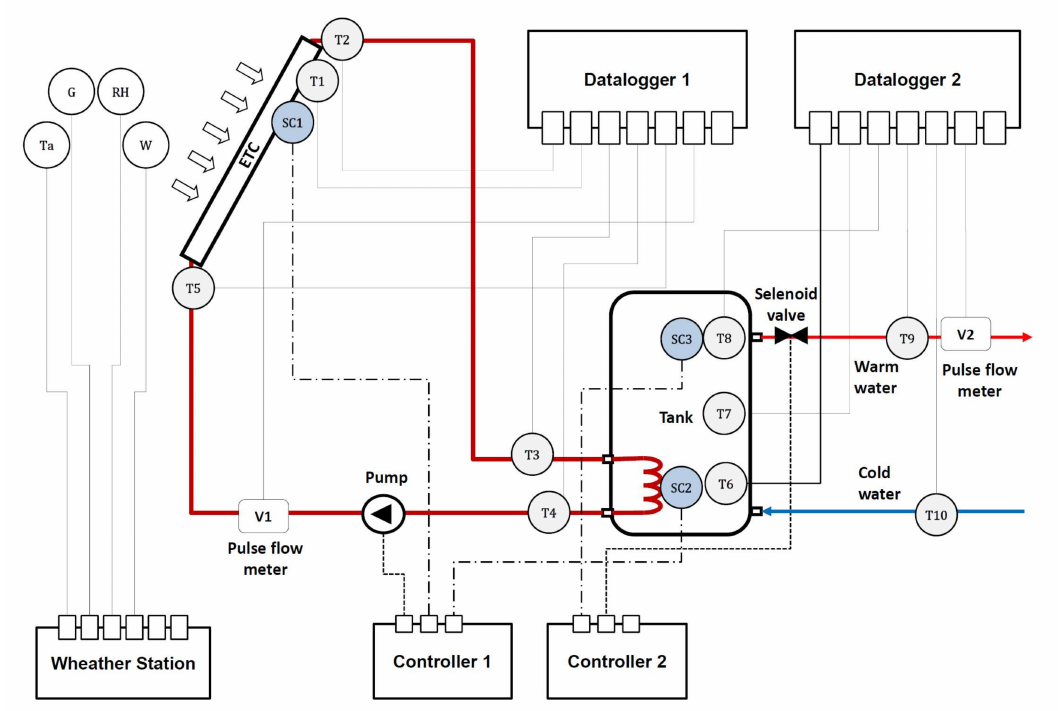
Figure 1. Main components of the active solar water heating system (SWHS) based on evacuated tube collectors (ETC)